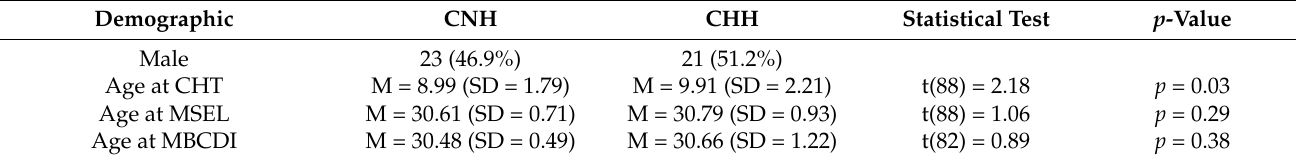
Table 1. Overall participant